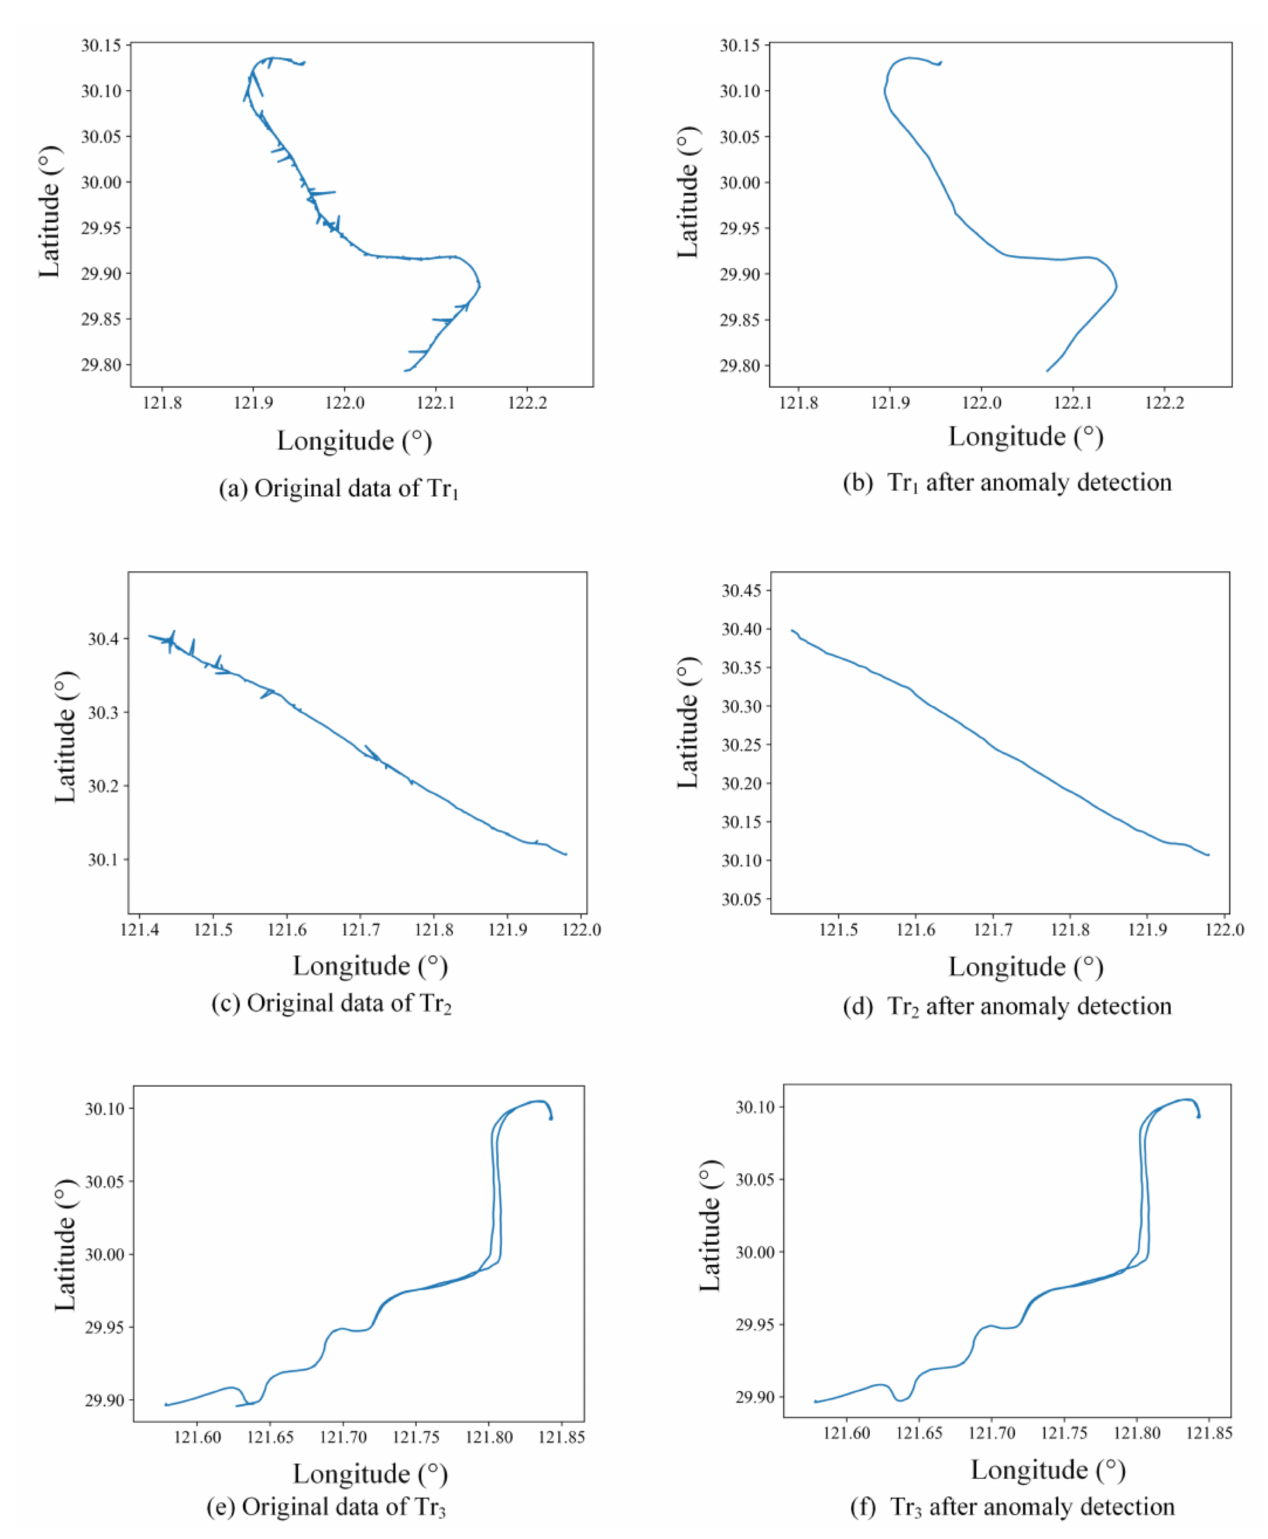
Figure 10. Comparison between the original trajectory and anomaly-removed